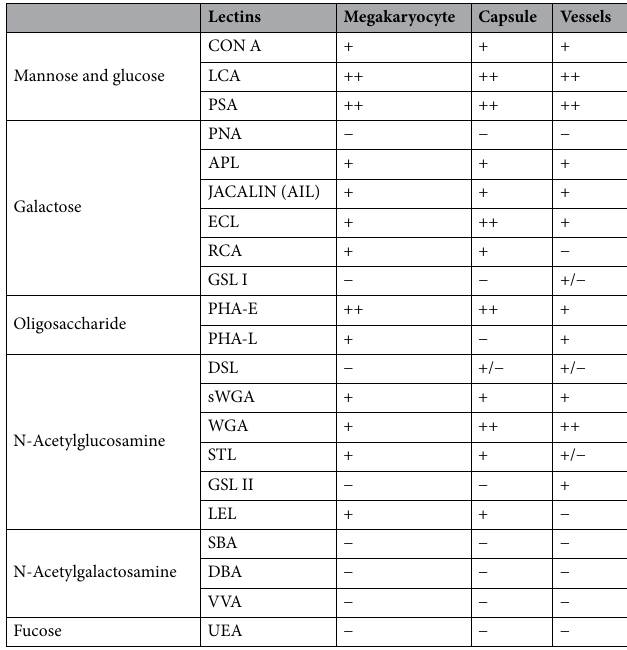
Table 1. Comparative table of lectins utilized: Evidenced structures and fetal liver cells. + Expressed, ++ intensely expressed, +/− Expressed at some developmental time points, − not expressed.